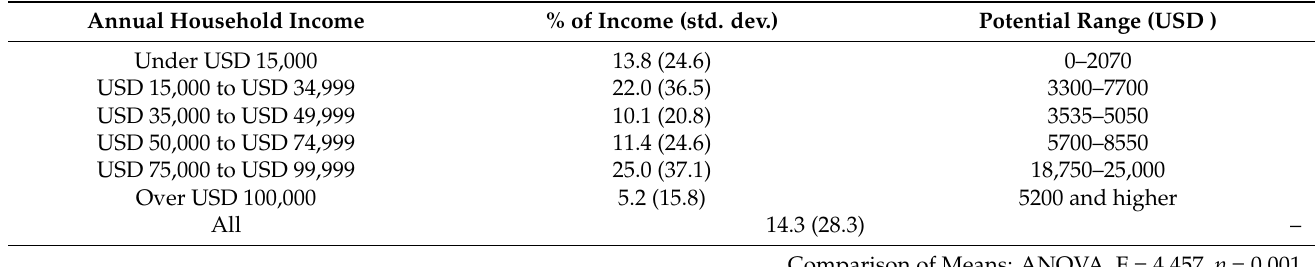
Table 8. Percentage of Annual Household Income Usually Received from Paid Work Activities or Side Jobs via EIWA for Hispanics.